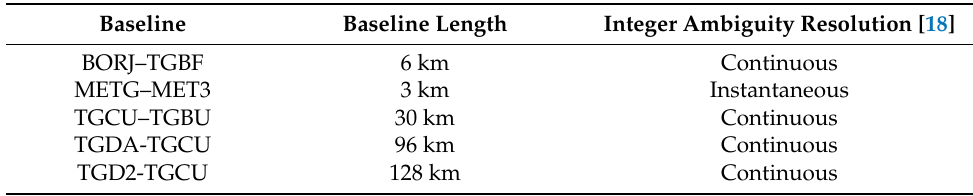
Table 2. Baseline information.